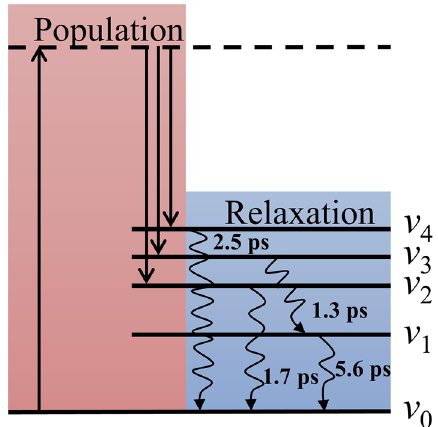
Figure 4. Energy level diagram describing the lattice mode dynamics of the RDX